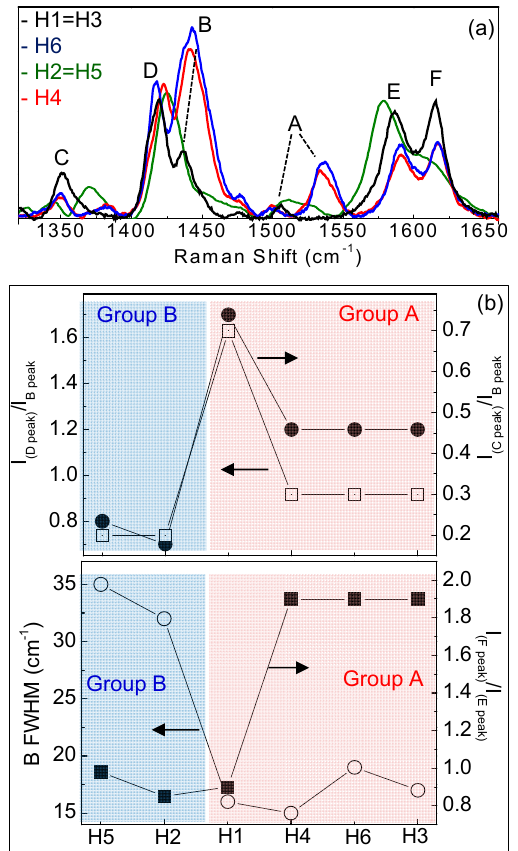
Figure 8. ( a ) Raman spectra in the range 1300–1650 cm − 1 ; ( b ) I Dpeak /I Bpeak ratio and I Cpeak /I Bpeak ratio and I Fpeak /I Epeak ratio and full width at half maximum (FWHD) of the B band for H1 – H6 .